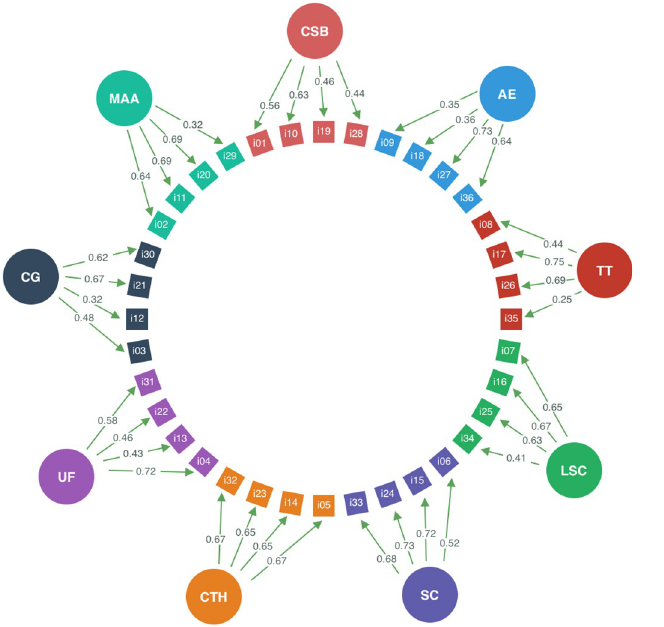
Fig 1. Item loadings in the nine multi-correlated model of the DFS-BR.